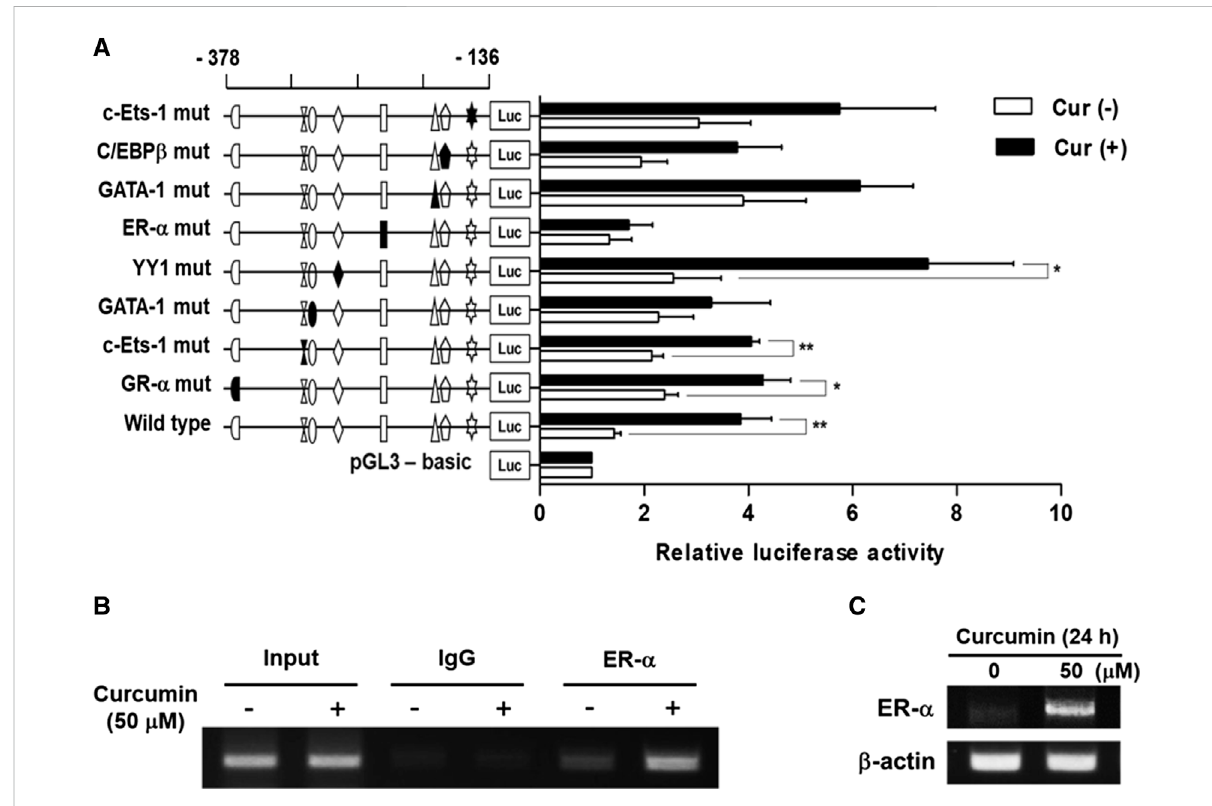
FIGURE 5 EffectofmutationsintheputativetranscriptionfactorbindingsitesonhST6GalNAcIpromoteractivityandChIPassay. (A) Themutationmarkof promoter construction is indicated by closed form or opened form (wild-type). Each construct was transfected into HCT116 cells, with pRL-TK co- transfectedasaninternalcontrol.Thetransfectedcellswereincubatedinthepresence(solidbar)orabsence(openbar)of50 µMcurcuminfor24 h. Relative fi re fl y luciferase activity was measured using the Dual-Luciferase Reporter Assay System, and all fi re fl y activity was normalized to the Renilla luciferase activity derived from pRL-TK. The values represent the means ± SEM of three independent experiments with triplicate measurements.Symbolsfortranscriptionfactorbindingsitesaredisplayedandsolidsymbolsshowthemutatedsites.* p < 0.05,** p < 0.01and*** p < 0.001 compared with curcumin-untreated cells. (B) ChIP assay was conducted in curcumin-treated HCT116 cells, or non-treated cells with input control (without antibody), nonspeci fi c immunoglobulin (IgG), and ER- α antibody. The -333 and -138 region (195 bp) of the hST6GalNAc I promoter onimmunoprecipitatedchromatinobtainedfromHCT116cellstreatedwithorwithoutcurcuminwasampli fi edbyPCR. (C) Aftertreatmentof50 μ M curcumin for 24 h, mRNA levels of ER- α were analyzed by RT-PCR using the extracted total RNAs. β -actin mRNA was also analyzed as an internal